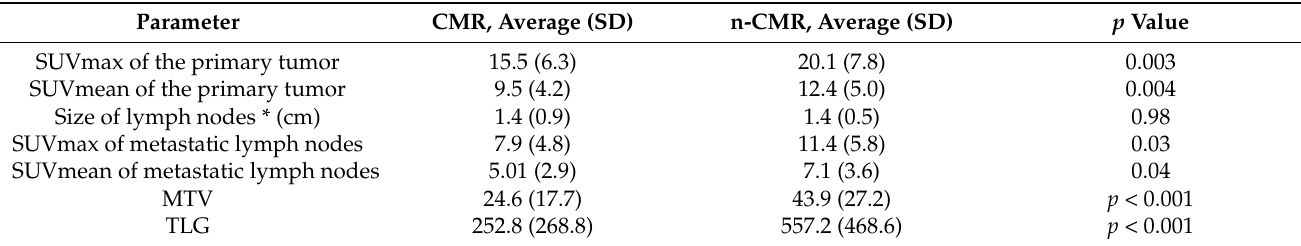
Table 2. Metabolic parameters at the staging of patients with CMR and n-CMR.